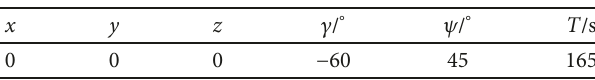
Table 1: Terminal constraints.